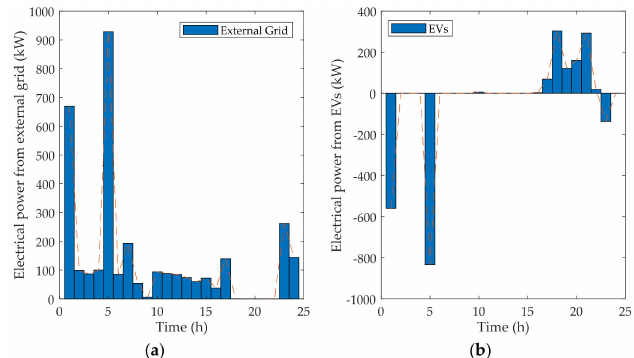
Figure 15. Electrical power supply in Case 2: ( a ) from the external grid and ( b ) from EVs.